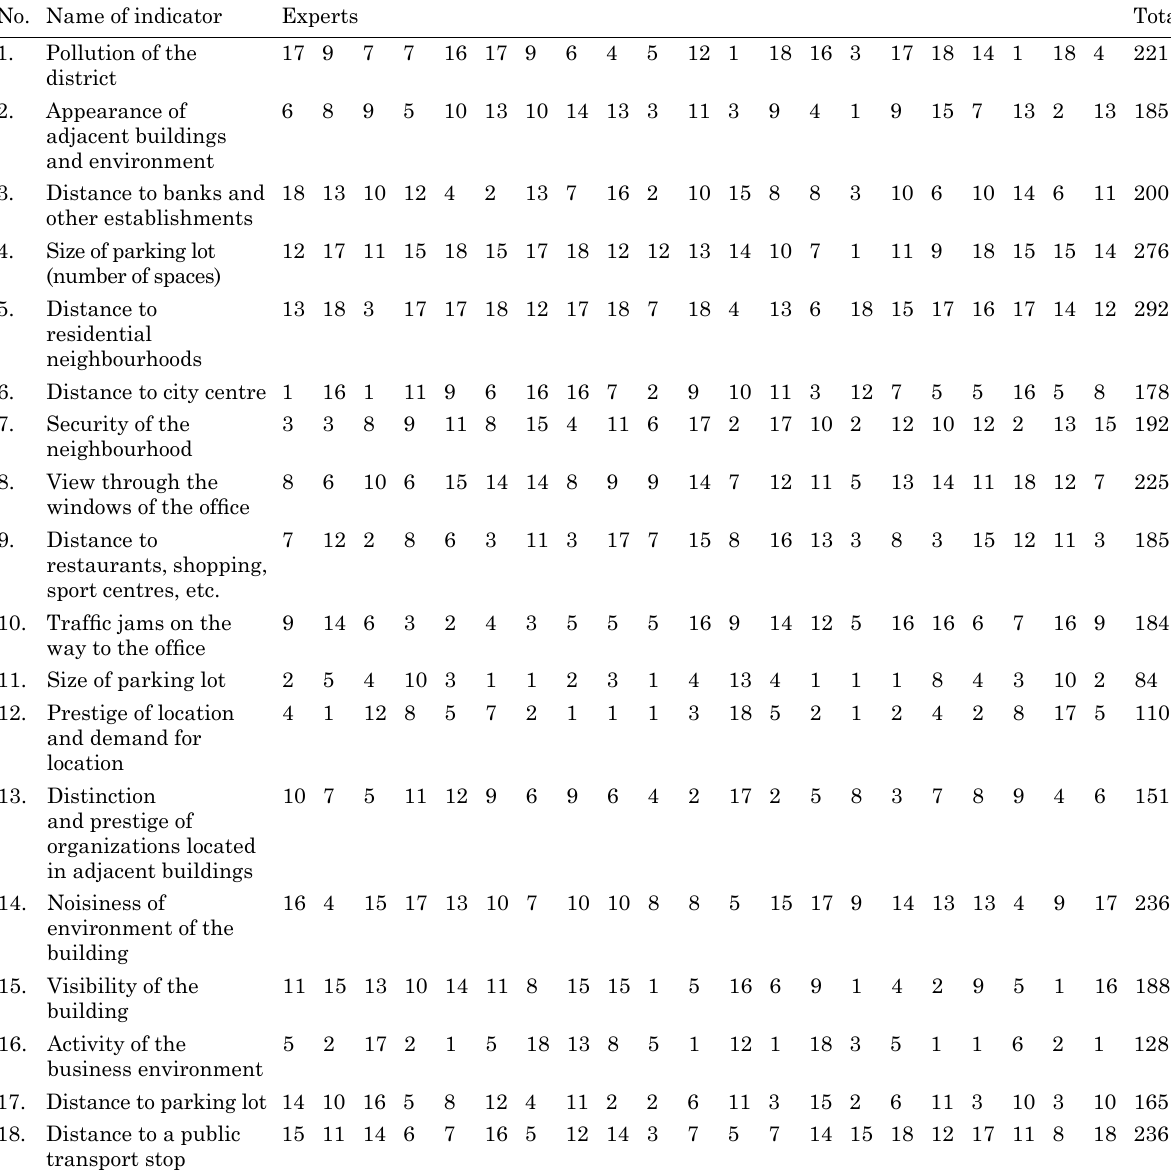
table 4. results of ranking of importance of environment indicators